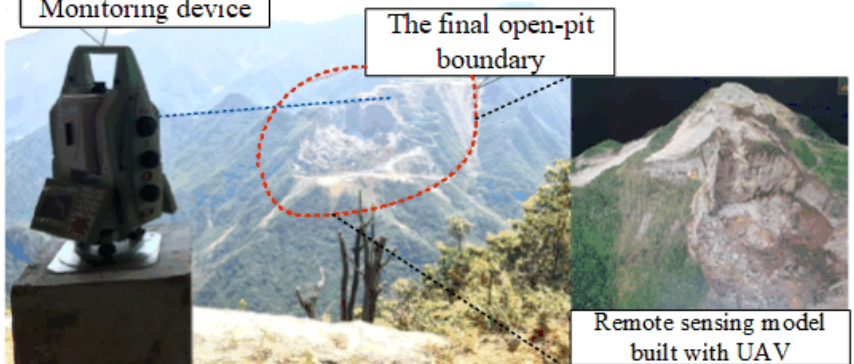
Figure 13. The photo of monitoring equipment at Shizhuyuan mine.